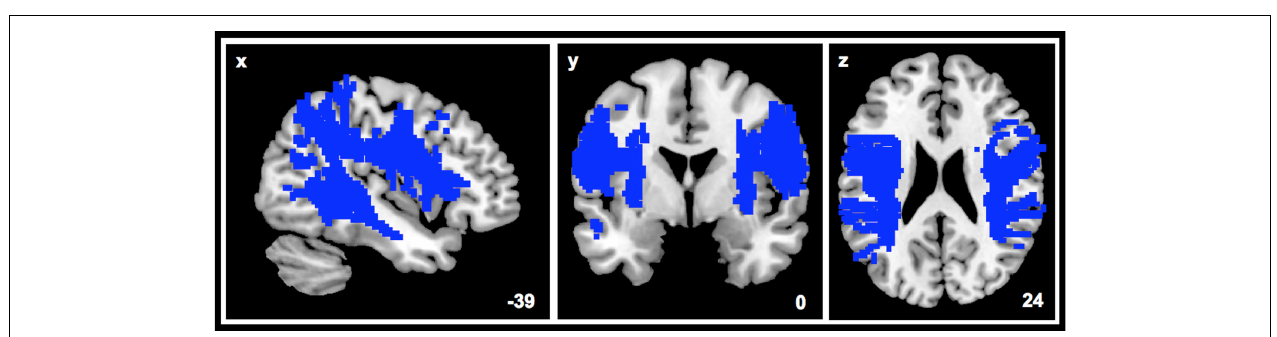
all suprathreshold voxels within the defi ned ROIs ( p < 0.05). Asterisks indicate signifi cant inter-hemispheric within-group differences (* p < 0.05) as a result of t -tests for paired samples (two-tailed). Moreover, the between-group analysis (two-way ANOVA) revealed a signifi cant interaction expertise × hemisphere .